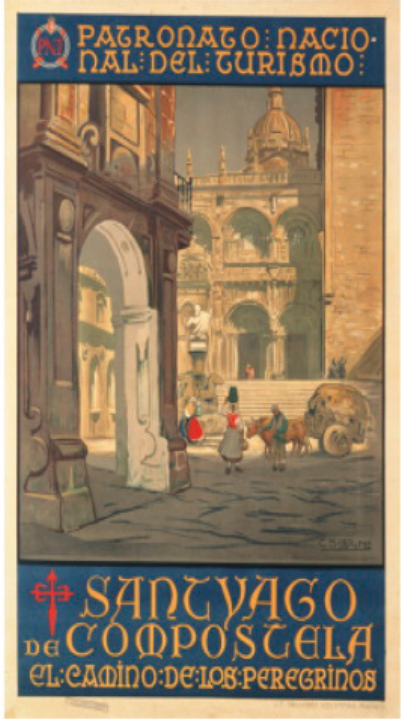
Figure 4. The Spanish government’s first tourism intervention to promote the city of Santiago as a destination for The Way for Jacobean Year 1926 (Carlos Sobrinos).